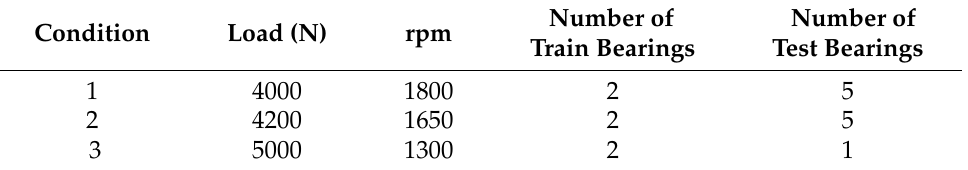
Table 1. Summary of the Pronostia